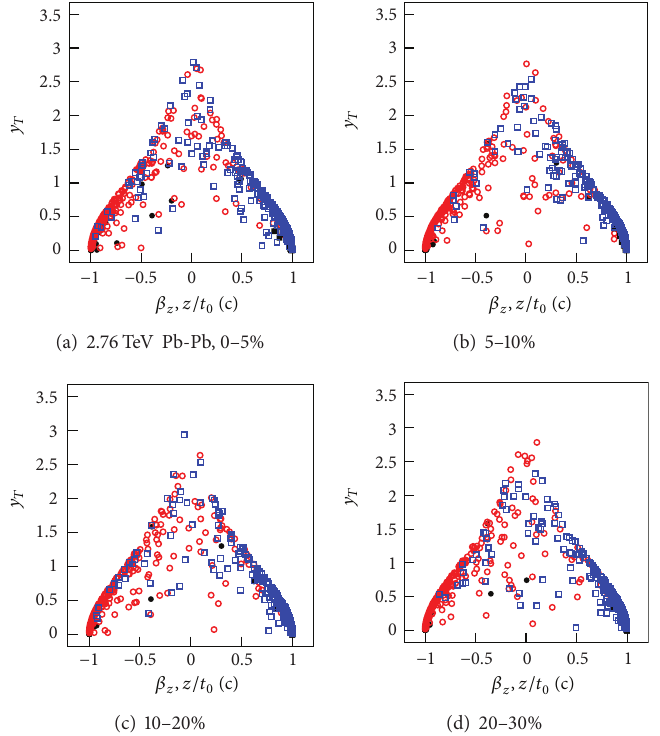
Figure 14: The same as for Figure 4, but showing the results in the space 𝑦 𝑇 − 𝛽 𝑧 (or 𝑦 𝑇 − 𝑧/𝑡 0